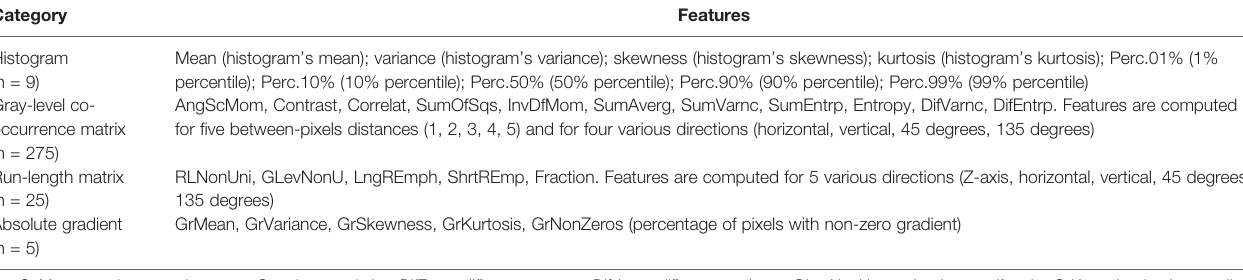
TABLE 1 | List of texture features in the MaZda